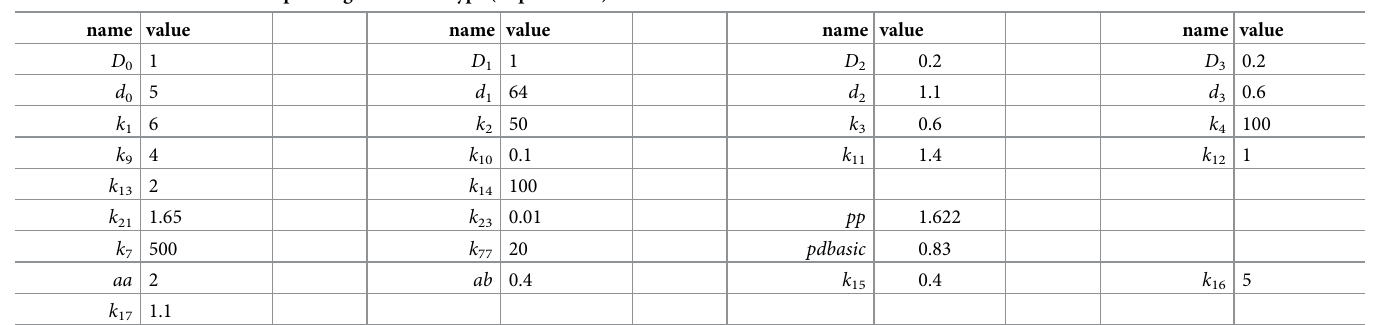
Table 1. Parameter values corresponding to the wild type (unperturbed) scenario.